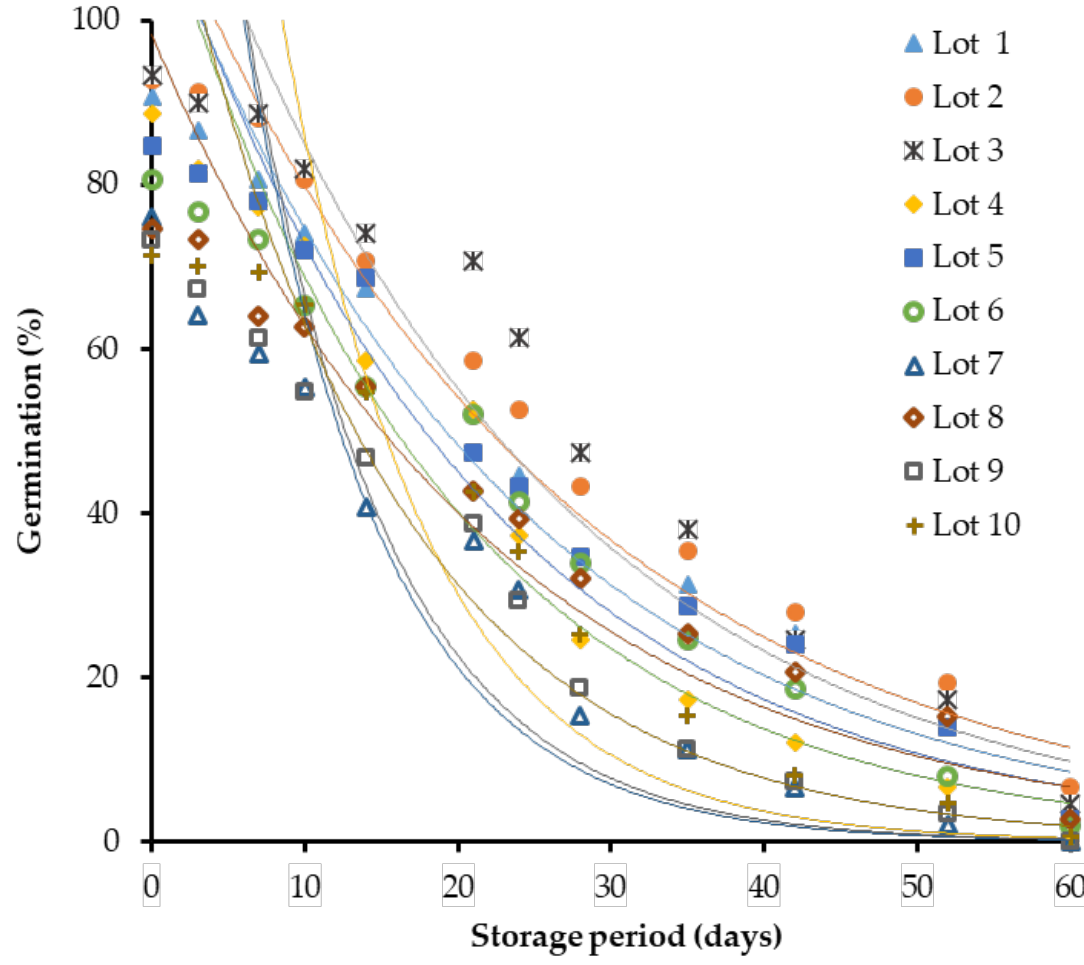
Figure 2. Survival curves of the seeds of ten onion ( Allium cepa L.) seed lots stored at 35 ± 2 °C and 75% relative humidity over 60 days.